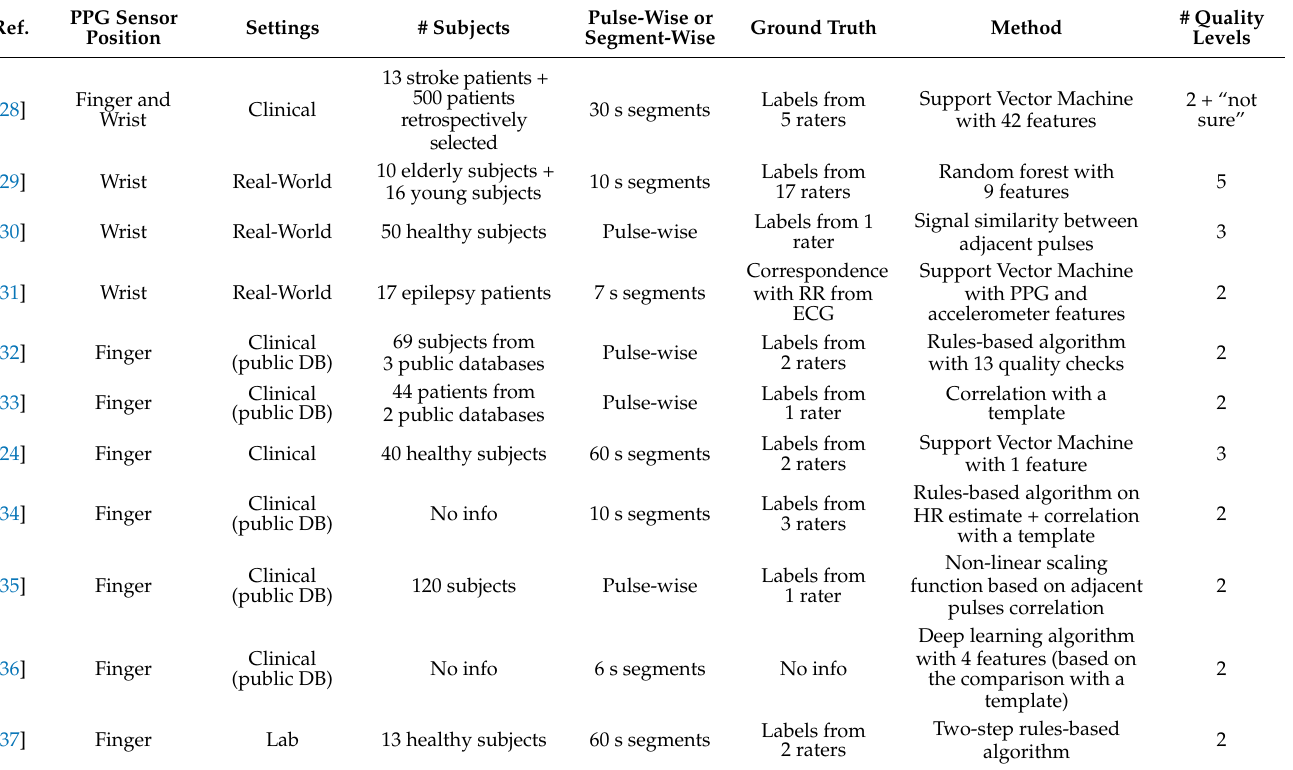
Table 1. State of the art for the PPG signal quality